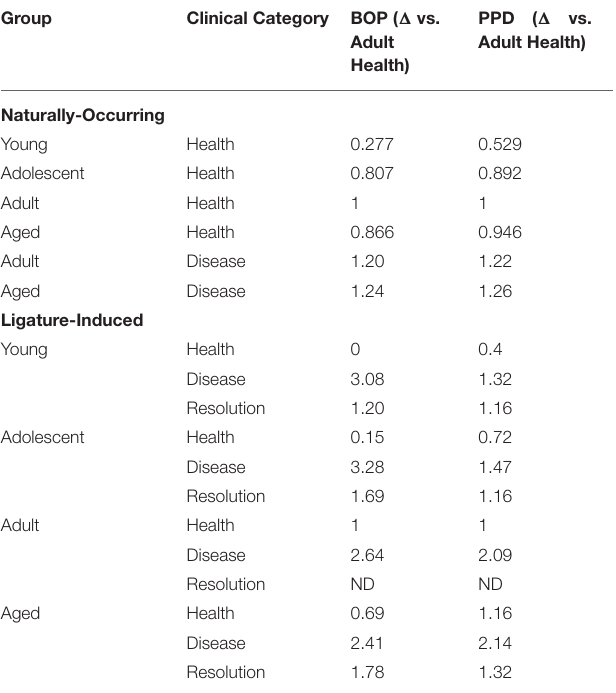
TABLE 1 | Clinical features of naturally occurring (full-mouth measures) and ligature-induced disease (only ligated-teeth) in the nonhuman primates.